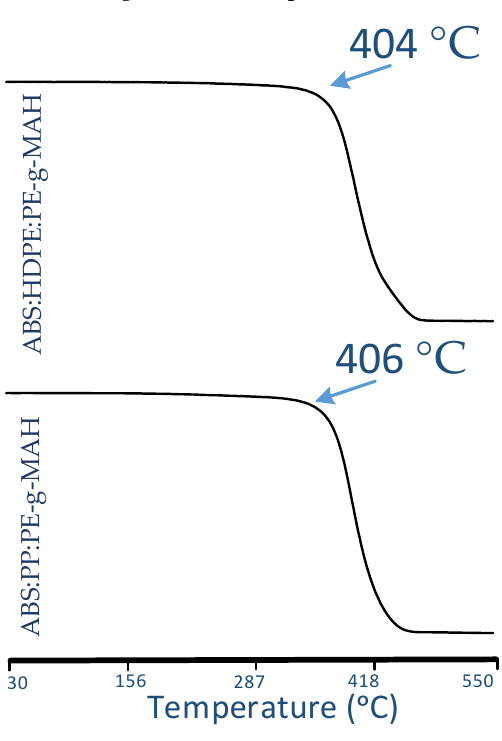
Figure 7. TGA analysis for blends.